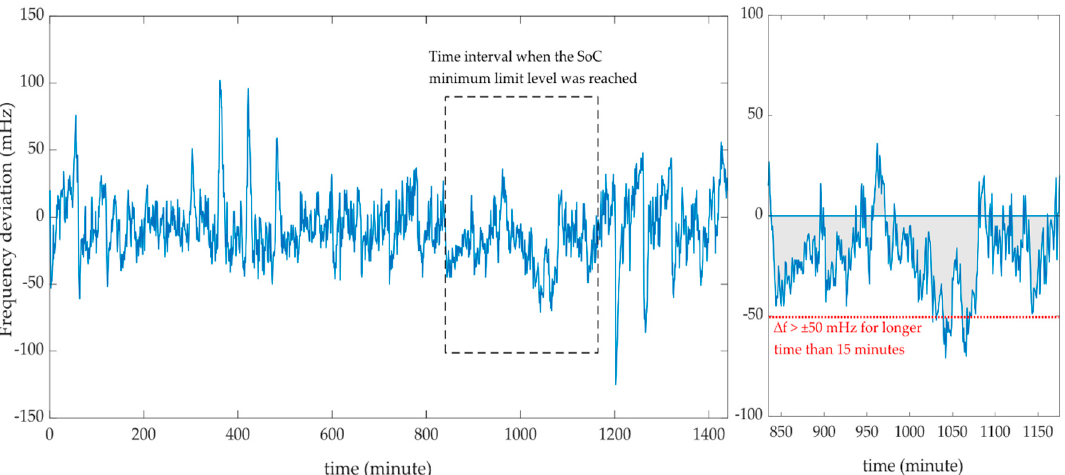
Figure 16. Example of the frequency deviation curve of the day the BESS reached the minimum allowed SoC level during the normal operation state of the grid.